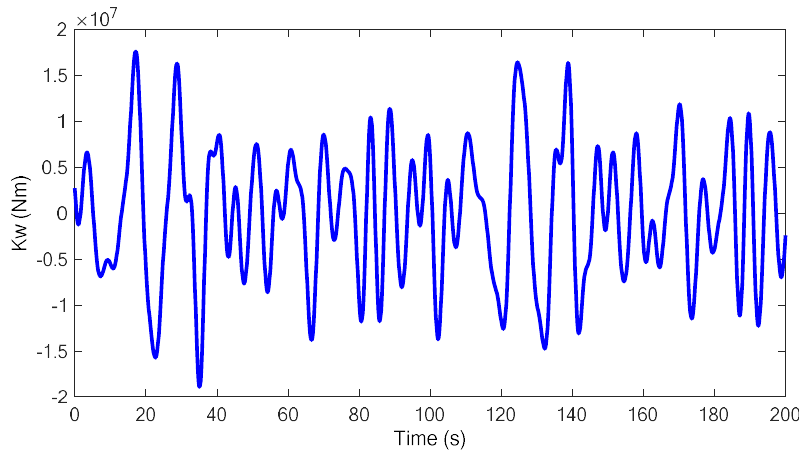
Figure 3. Time history curve of the ship rolling disturbance moment.